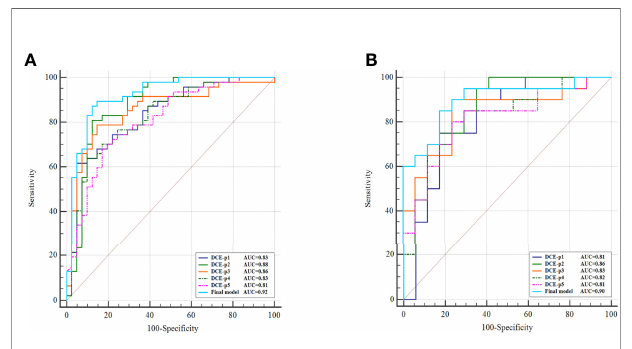
FIGURE 3 | Comparison of single phase enhancement and the fi nal model of radiomics. ROC curves of single phase enhancement and the fi nal model on training cohort (A) and external validation cohort